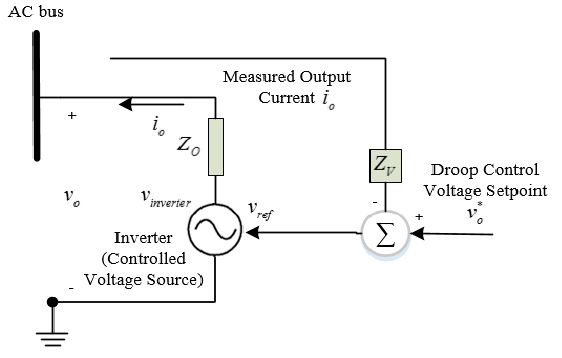
Figure 6. Virtual Impedance Loop.